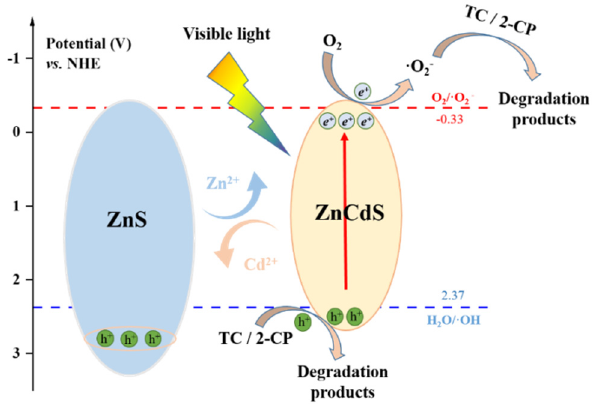
Figure 12. Possible photocatalytic mechanism of photocatalytic TC degradation and 2-CP degrada- tion.